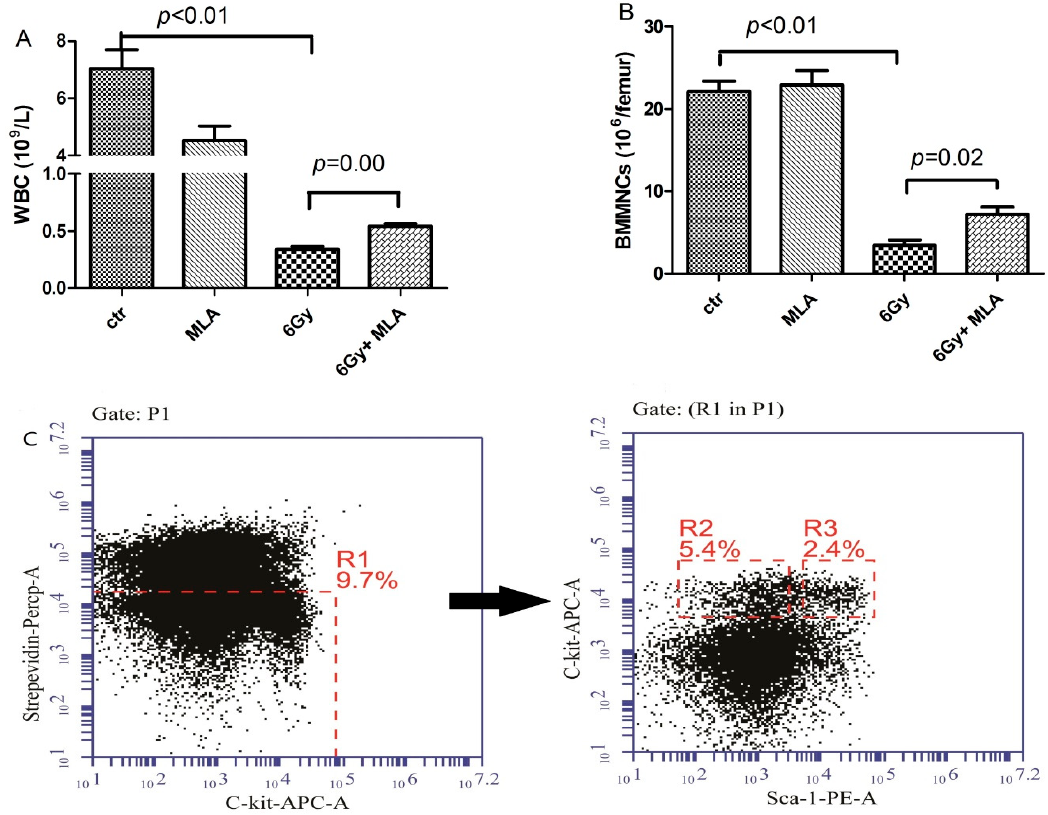
Figure 3. Figure 3. Cont.